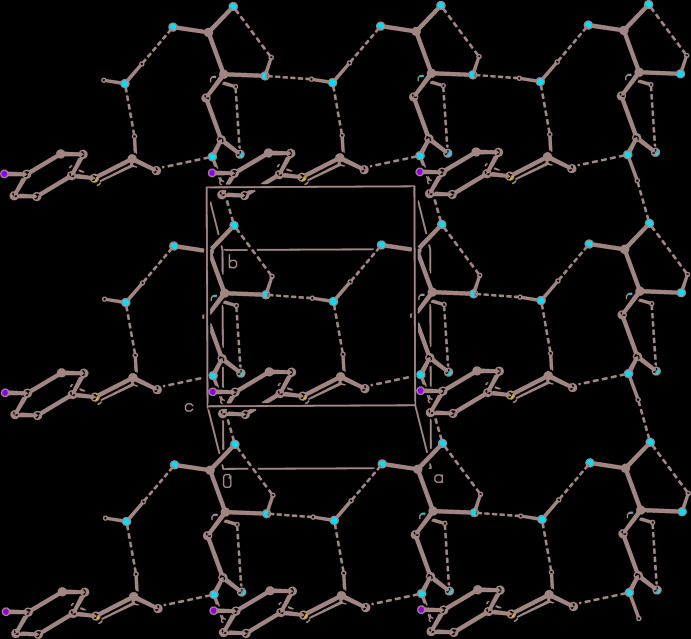
Part of the crystal structure of compound (III) showing the formation of a hydrogen-bonded sheet lying parallel to (001). Hydrogen bonds are drawn as dashed lines and, for the sake of clarity, the H atoms bonded to C atoms have been omitted.